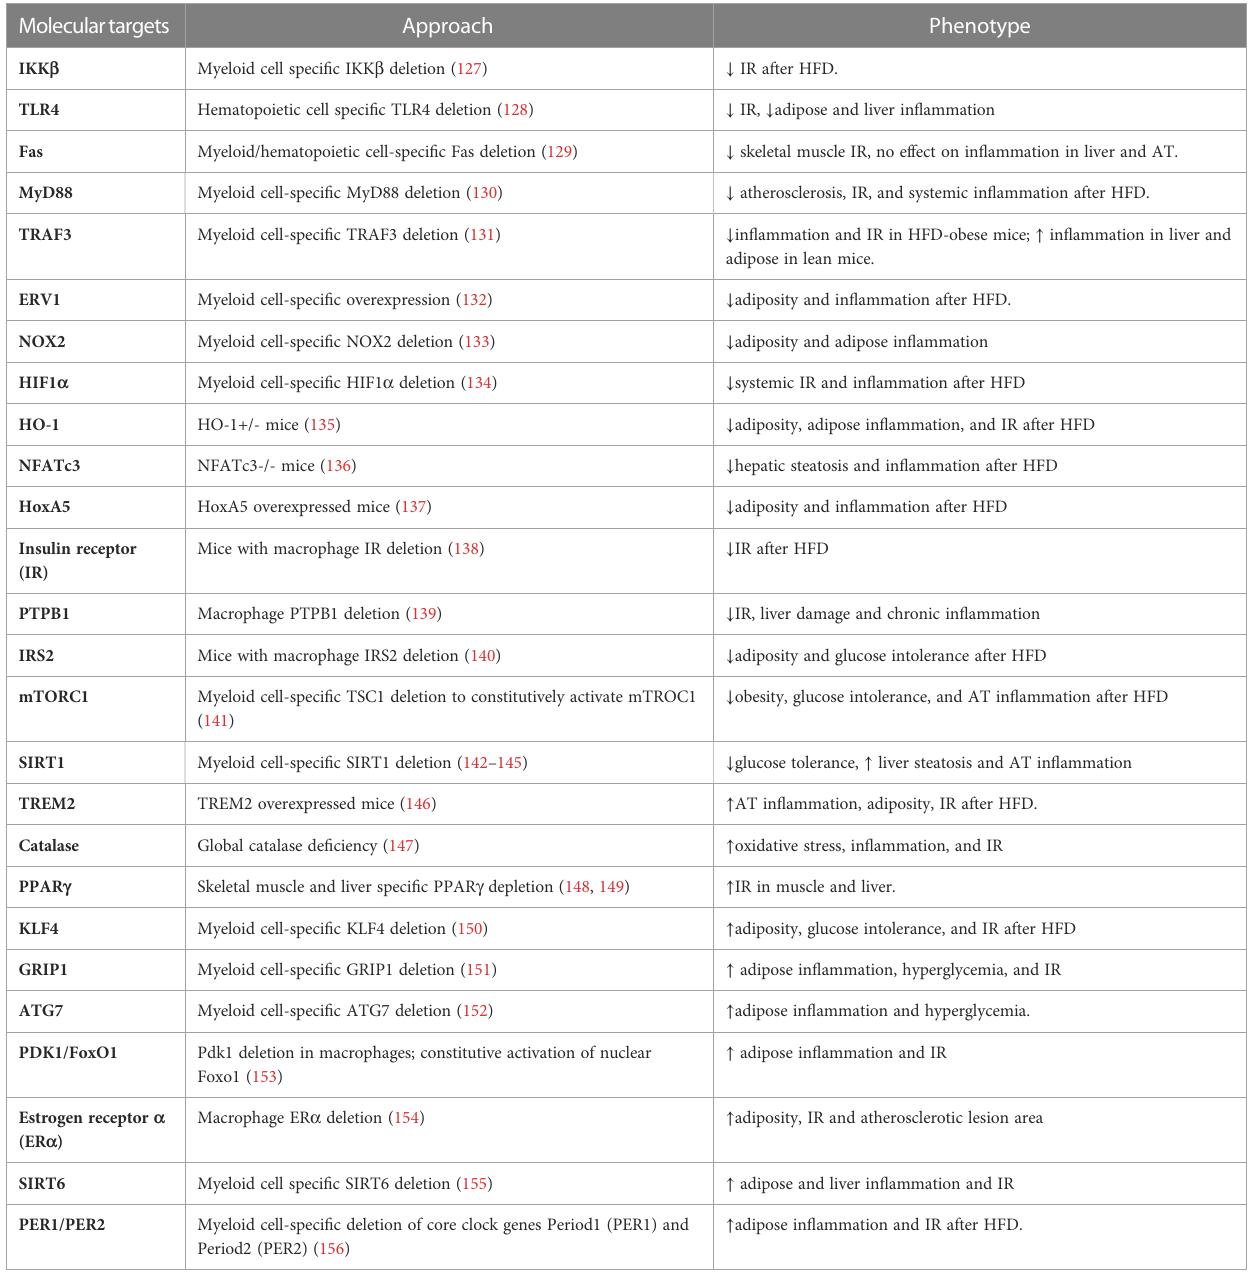
TABLE 2 Targeting macrophages for improving metabolic health. Moleculartargets